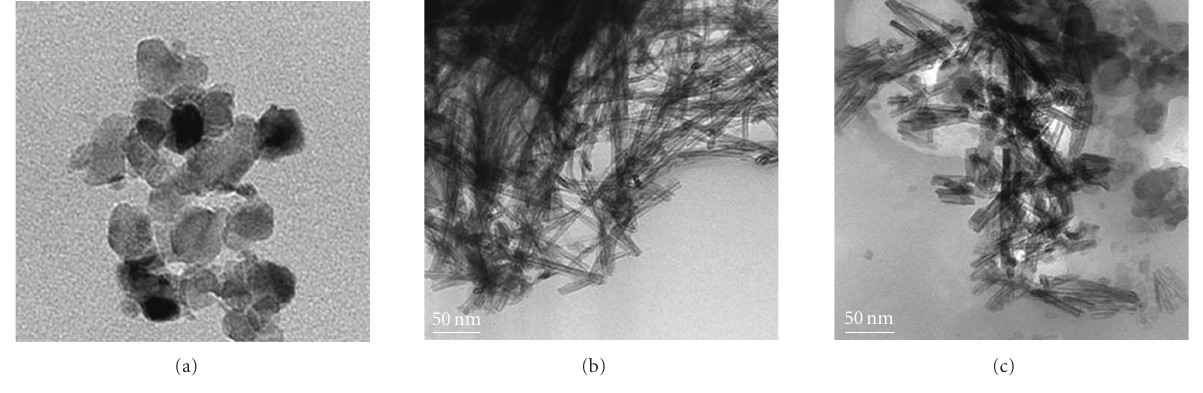
Figure 1: TEM micrographs of (a) TiO 2 nanoparticles, (b) pure TNT (c) 5% Gd 3+ -TNT.